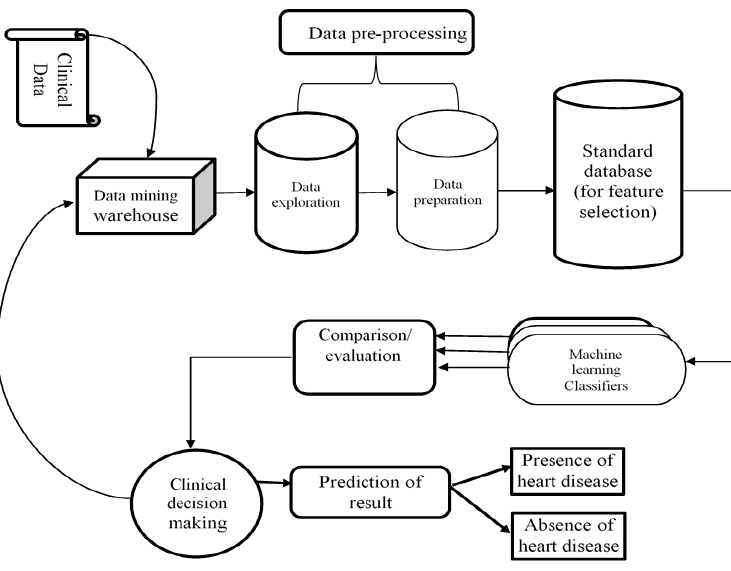
Fig 2. Data mining methodology and heart disease prediction process